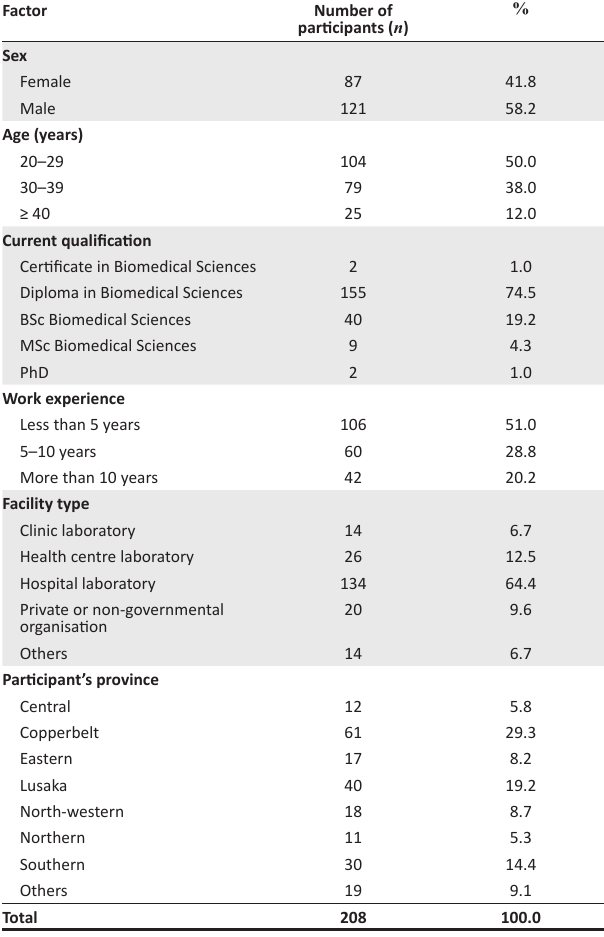
TABLE 1 : Demographic characteristics of medical laboratory professionals, Zambia, June 2020. Factor